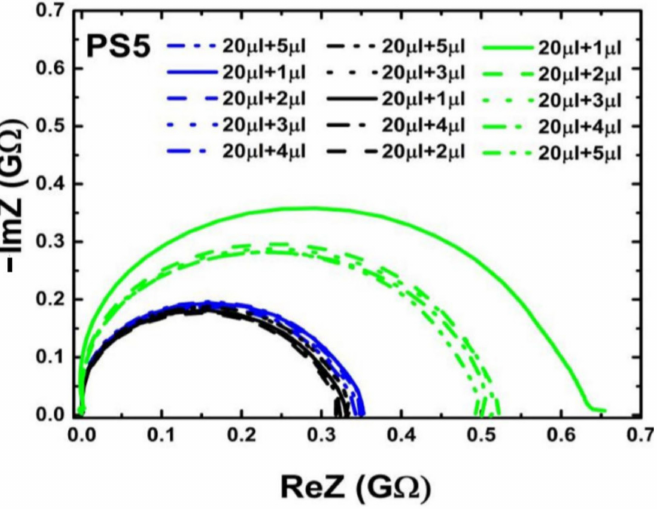
Figure 8. Nyquist plot of extracted effective impedance (Z( ω )) from the equivalent circuit model Figure 6b for PS5. The extracted effective impedance is represented for dead (black lines), for live (green lines), and for DI water sample (blue lines). Not fully systematic/systematic change of effective impedance (ReZ and Im Z) when adding liquid with dead/live cells to 20 µ L DI water is